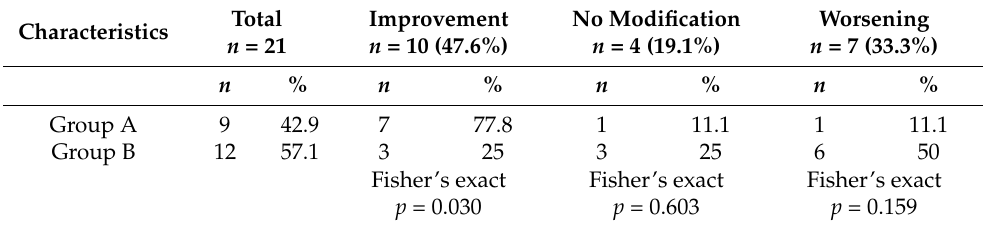
Table 3. Sequestrectomy with autologous fat graft and relative clinical trend after surgery. Characteristics